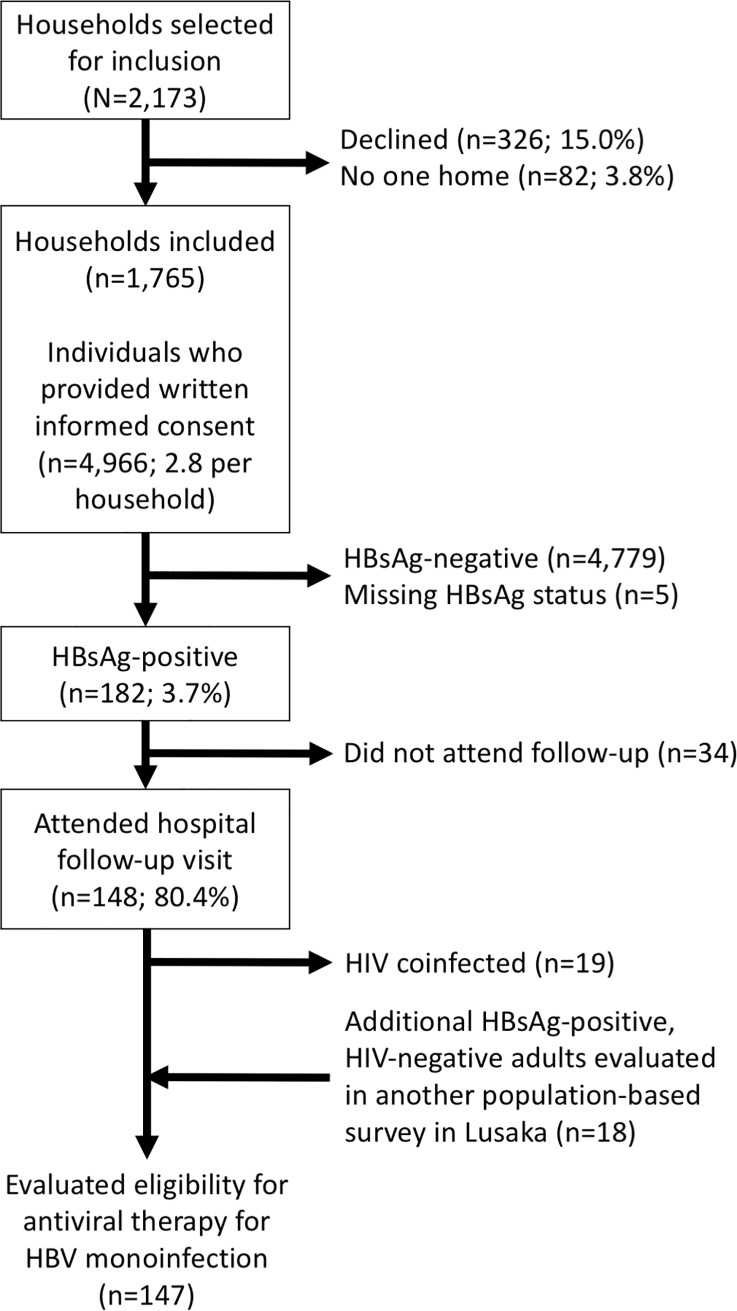
Recruitment flow diagram.